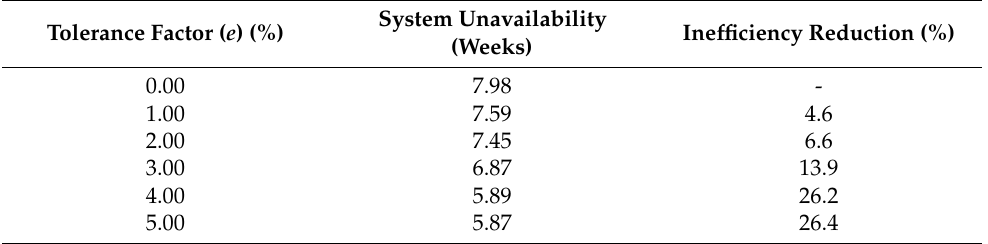
Table 5. Results of unavailability of the system and reduction of inefficiency, for different tolerance